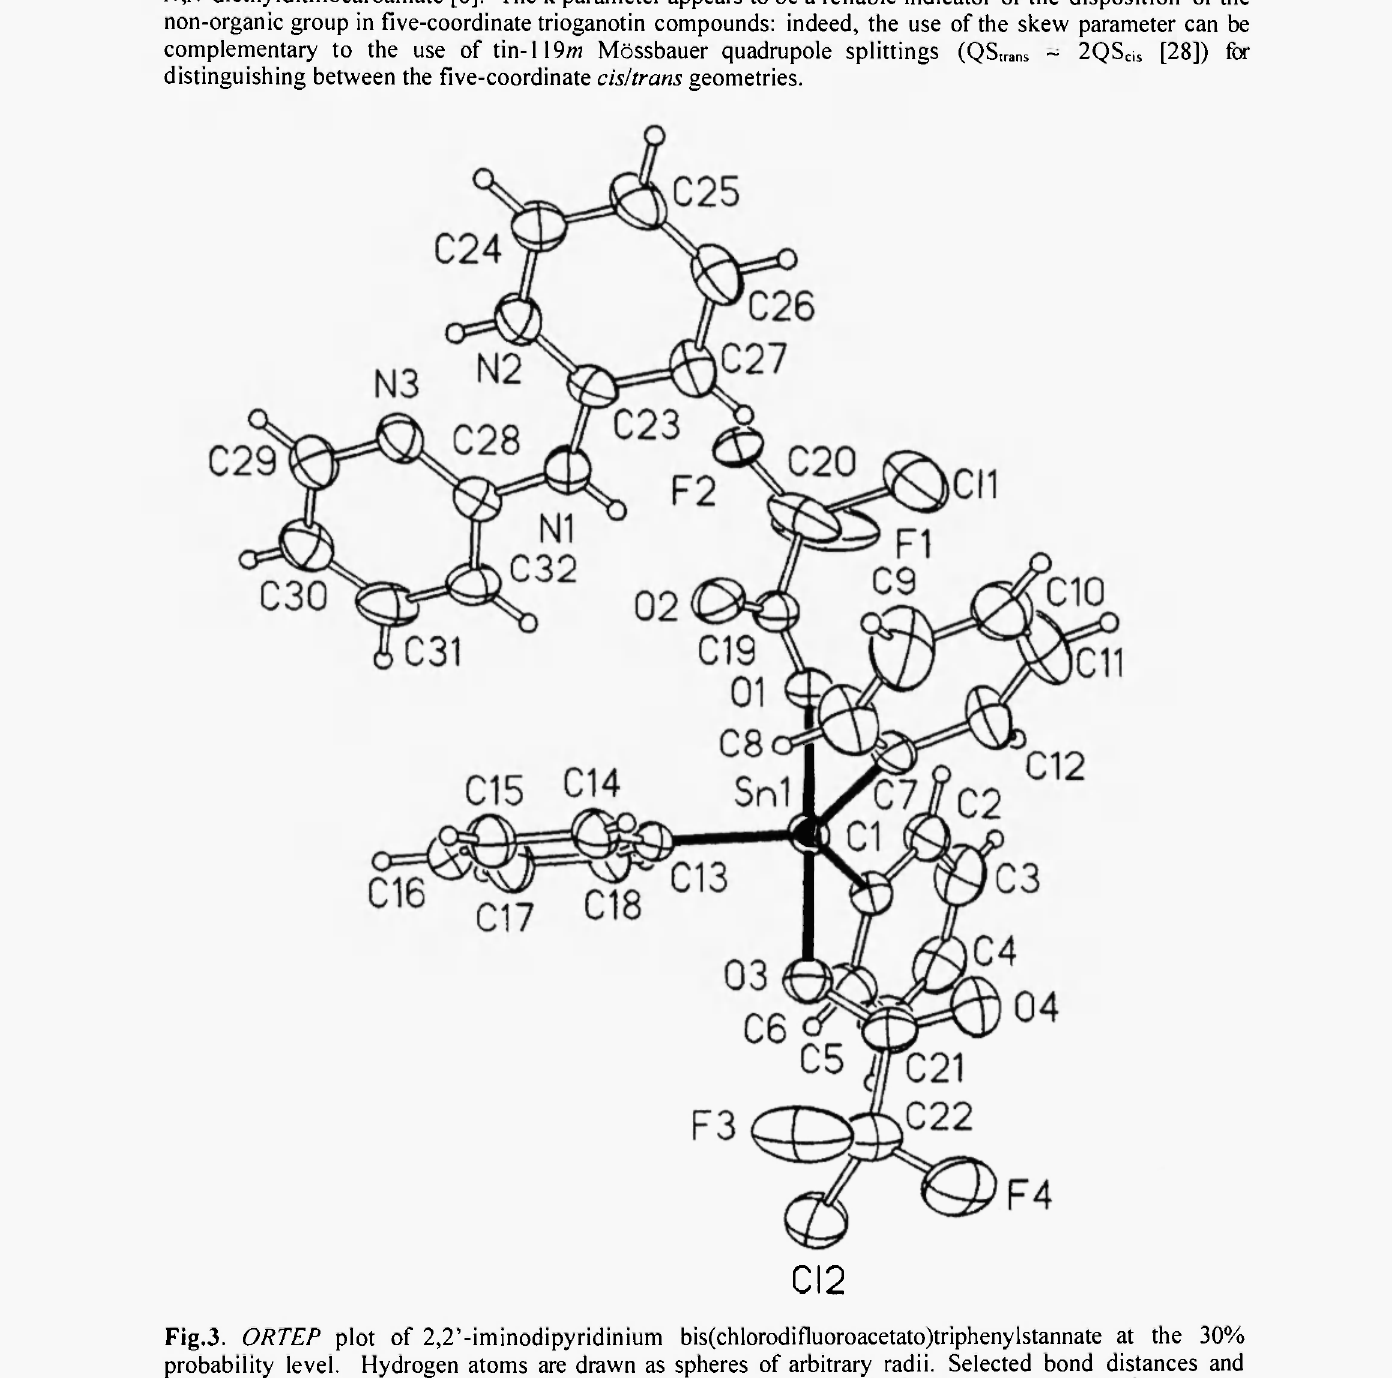
Fig. 3. ORTEP plot of 2,2'-iminodipyridinium bis(chlorodifluoroacetato)triphenylstannate at the 30% probability level. Hydrogen atoms are drawn as spheres of arbitrary radii. Selected bond distances and angles: Snl-Cl 2.131(3) A, Snl-C7 2.123(4) A, Snl-C13 2.129(4) A, Snl-Ol 2.310(5) A, Snl-03 2.194(5) A; Cl-Sn7-Cl 123.1(2)°, Cl-Snl-C13 14.1(2)°, Cl-Snl-Ol 86.0(2)°, Cl-Snl-03 94.0(2)°, 122.3(2)°, C7-Snl-01 84.0(2)°, C7-Snl-03 96.3(2)°,